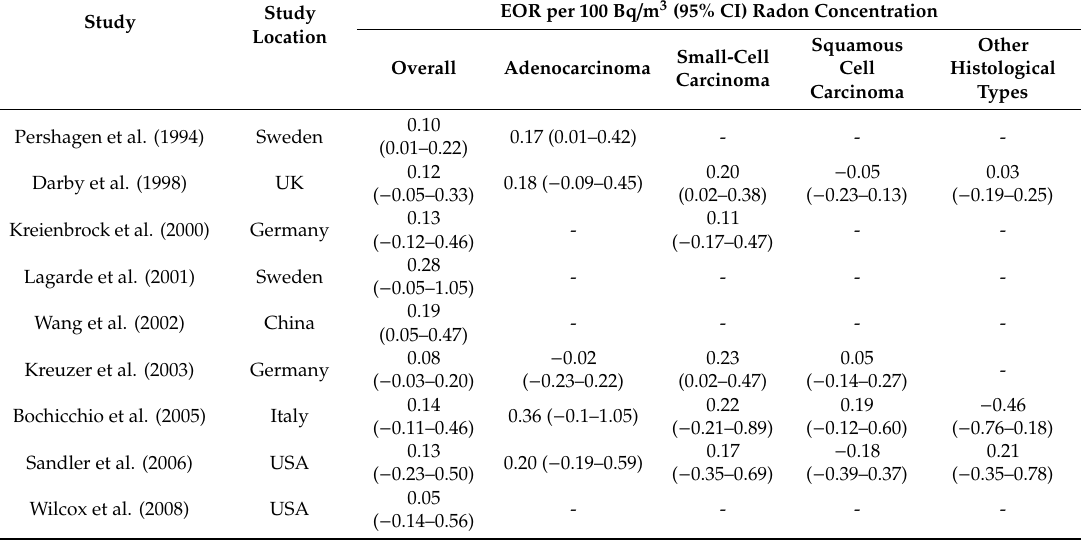
Table 3. Dose-response e ff ects of radon for lung cancer and histological